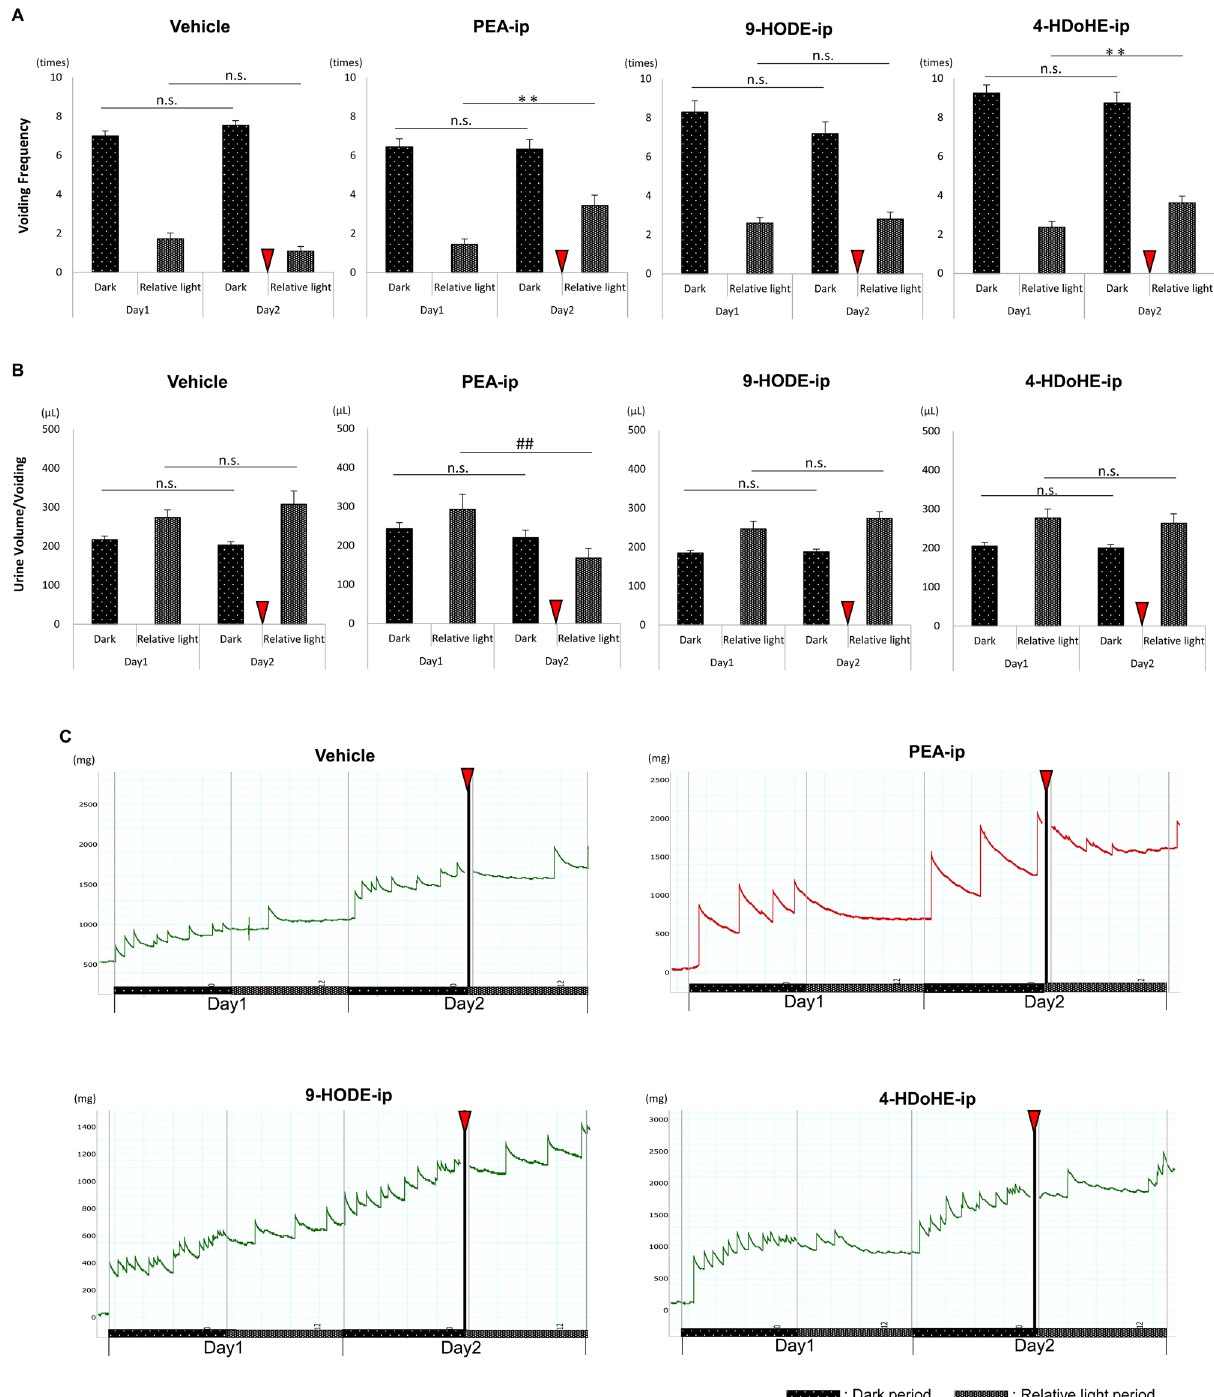
Figure 4. Differences in voiding behavior after intraperitoneal injection of the fatty acid metabolites under the constant dark cycle (DD) in wild type mice. Voiding frequency (VF) and urine volume per voiding (Uvol/v) were measured for 2 days and the parameters between the same phases (the dark phase on day 1 and day 2, or the relative light phase on day 1 and day 2) were compared. The intraperitoneal injections of vehicle, and 10 mg/kg each of PEA (PEA-ip), 9-HODE (9-HODE-ip), and 4-HDoHE (4-HDoHE-ip) were performed at the beginning of the relative light phase on day 2. ( A ) VF between the dark and relative light phases for 2 days in wild type (WT) mice. ( B ) Uvol/v between the dark and relative light phases for 2 days in WT mice. ( C ) Representative traces of voiding in WT mice after injecting vehicle, PEA, 9-HODE, and 4-HDoHE. Differences in VF were analyzed using paired t test. Differences in Uvol/v were analyzed using Mann–Whitney’s U -test. Data are presented as mean ± standard error (SE). p < 0.05 was considered significant. n.s., not significant. Red arrow heads indicate the time point of ip. ** p < 0.01 by paired t tests, ## p < 0.01 using Mann–Whitney’s U